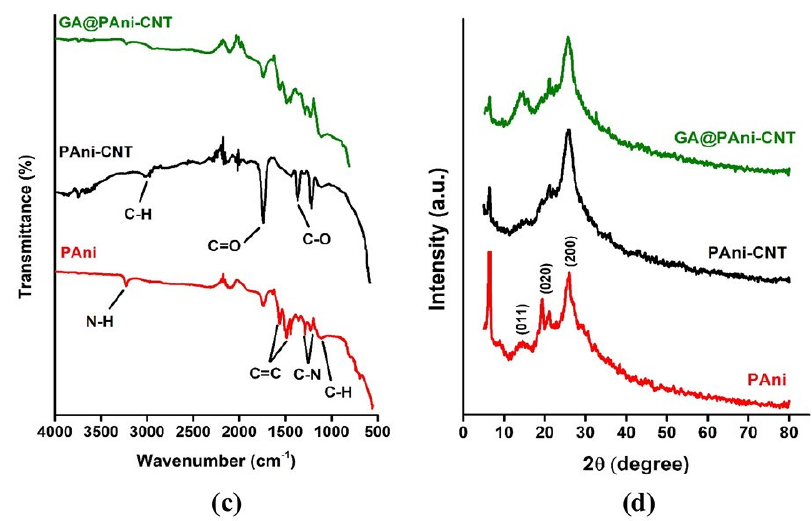
Figure 1. ( a ) UV–visible, ( b ) Raman, ( c ) FTIR, and ( d ) XRD spectra of PAni, PAni-CNT,